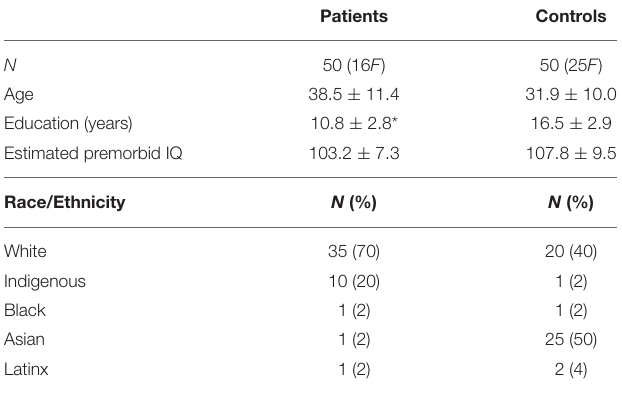
TABLE 3 | Substance use in